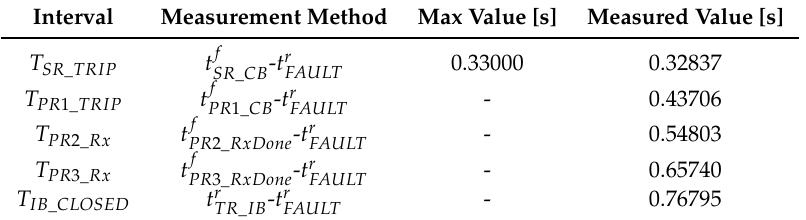
Table 18. Estimated time intervals during the fault 67N.S1 between SR and PR1, with a LoRa T packet of 103.42